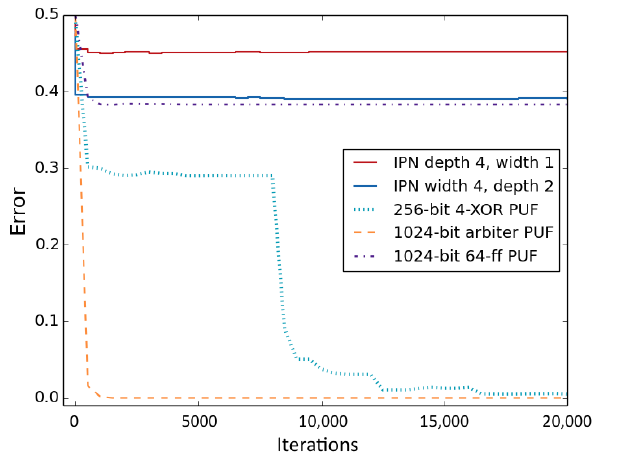
Figure 3. Best results in 100 logistic regression attacks using 30,000 challenge-response pair (CRP) training set on five Physical Unclonable Function (PUF)-based systems. Error vs.